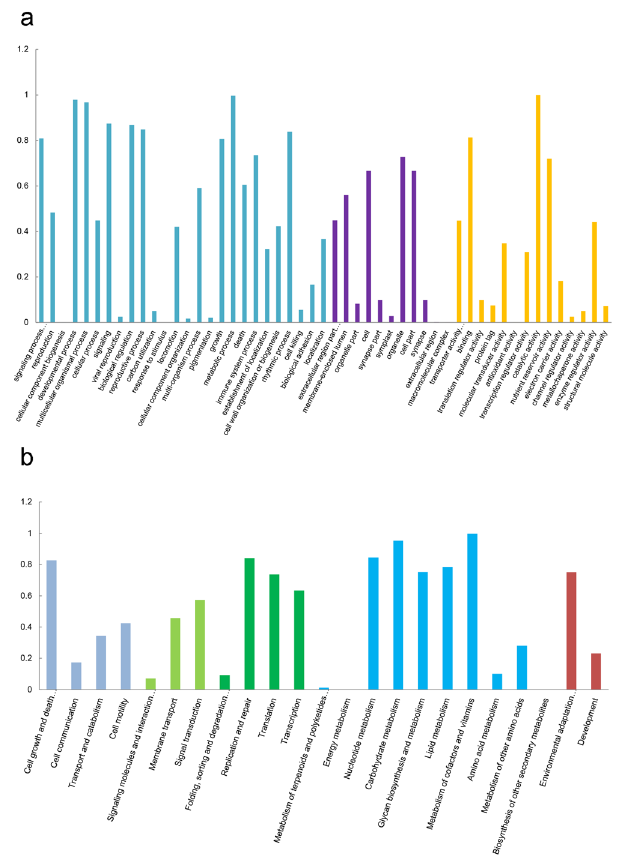
Figure 3. Gene enrichment analysis of differentially expressed genes in the transcriptome sequencing experiment. ( a ) GO enrichment analysis of all differentially expressed genes detected in this study; ( b ) KEGG enrichment analysis of all differentially expressed genes detected in this study.